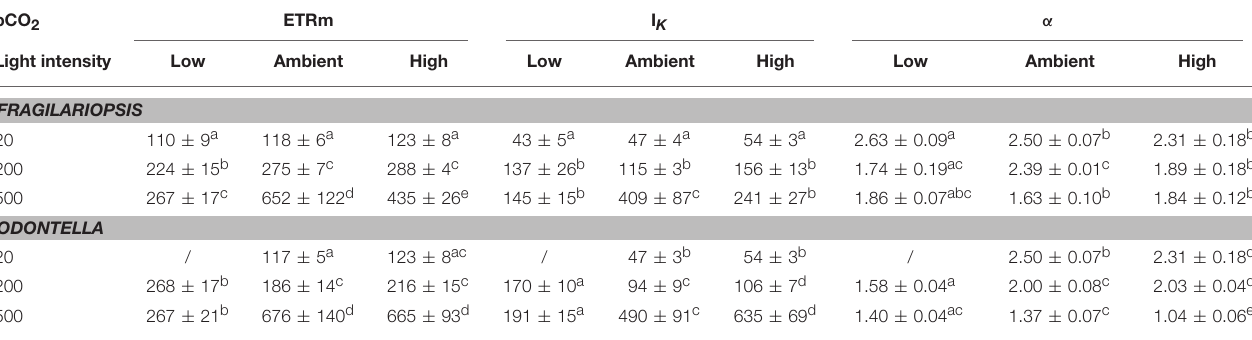
TABLE 2 | Photosynthetic parameters from photosynthesis-irradiance curve fits based on Ralph and Gademann (2005) maximum electron transport rate (ETRm, e − PSII − 1 s − 1 ), light saturation point (I K , µ mol photons m − 2 s − 1 ) and light use efficiency ( α , rel. unit) were determined for Fragilariopsis